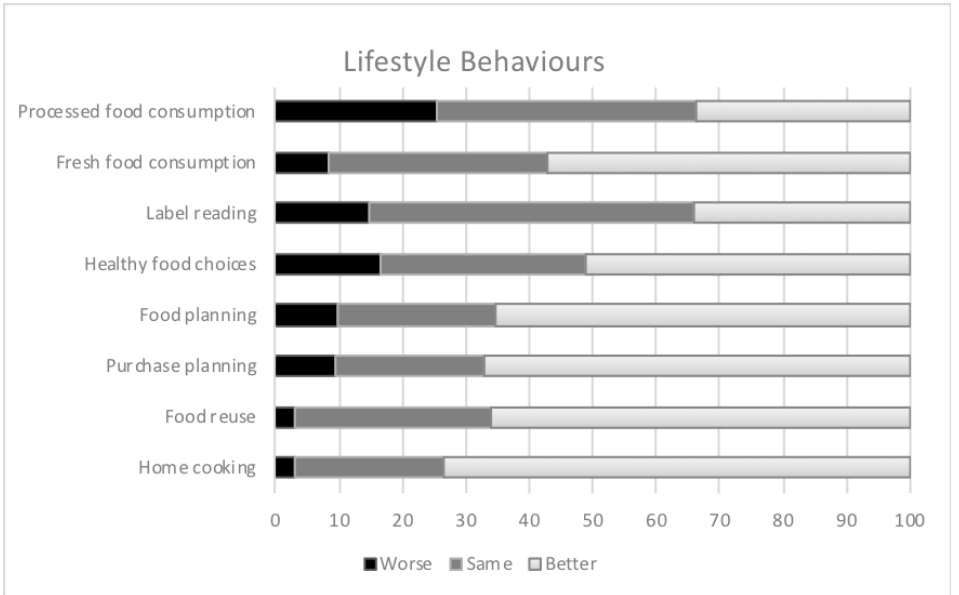
Figure 3. Changes in lifestyle behaviour during confinement. “Better” indicates an improvement in lifestyle behaviors; “same” indicates that lifestyle habits have been maintained; “worse” indicates a worsening of lifestyle behaviors.